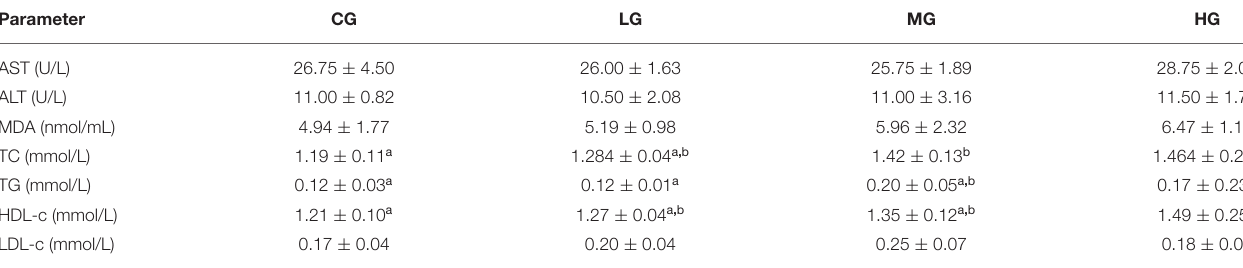
TABLE 1 | Levels of serum biochemistry parameters in mice from experiment and control groups. Parameter CG